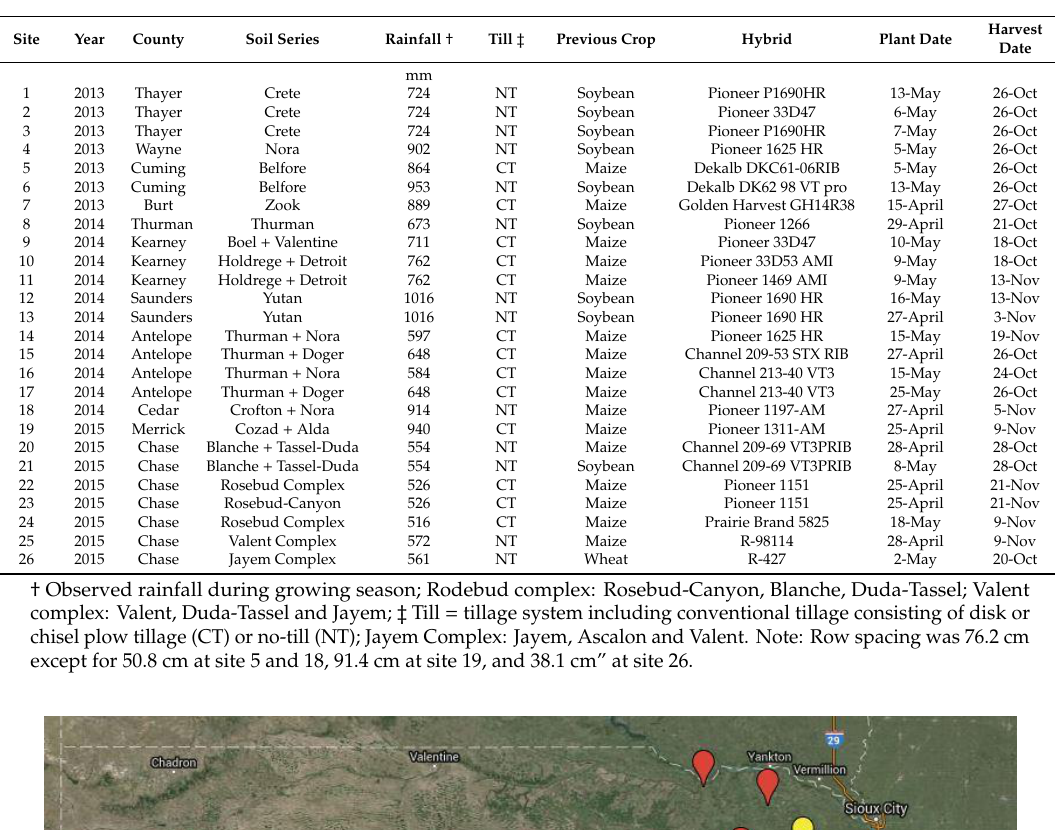
Table 1. Site background information and cultural practices for 26 field strip trials testing foliar micronutrient application for irrigated maize but for popcorn at site 25 and 26.